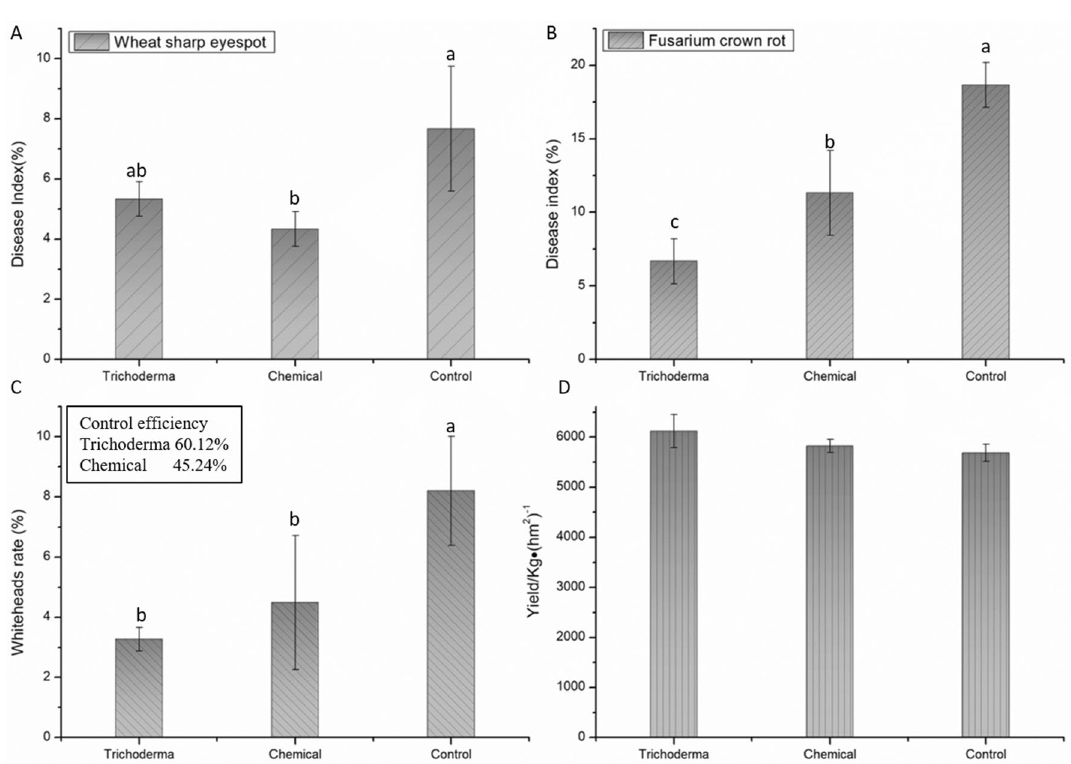
Figure 6. Impact of T. atroviride HB20111 seed dressing ( Trichoderma ) and chemical fungicide seed dressing (Chemical) on the targeted wheat soil-borne diseases. The disease index of wheat sharp eyespot ( A ); the disease index of Fusarium crown rot ( B ); the whiteheads rate and control efficiency of different treatments ( C ); the yield of different treatments ( D